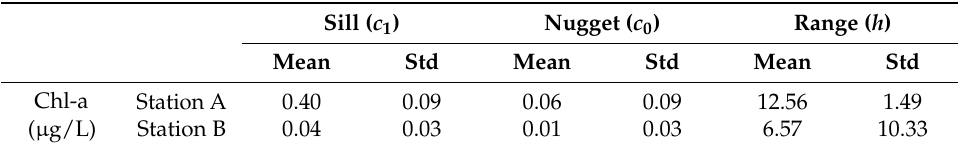
Table 3. Statistics of the temporal scale of Chl-a at Poyang